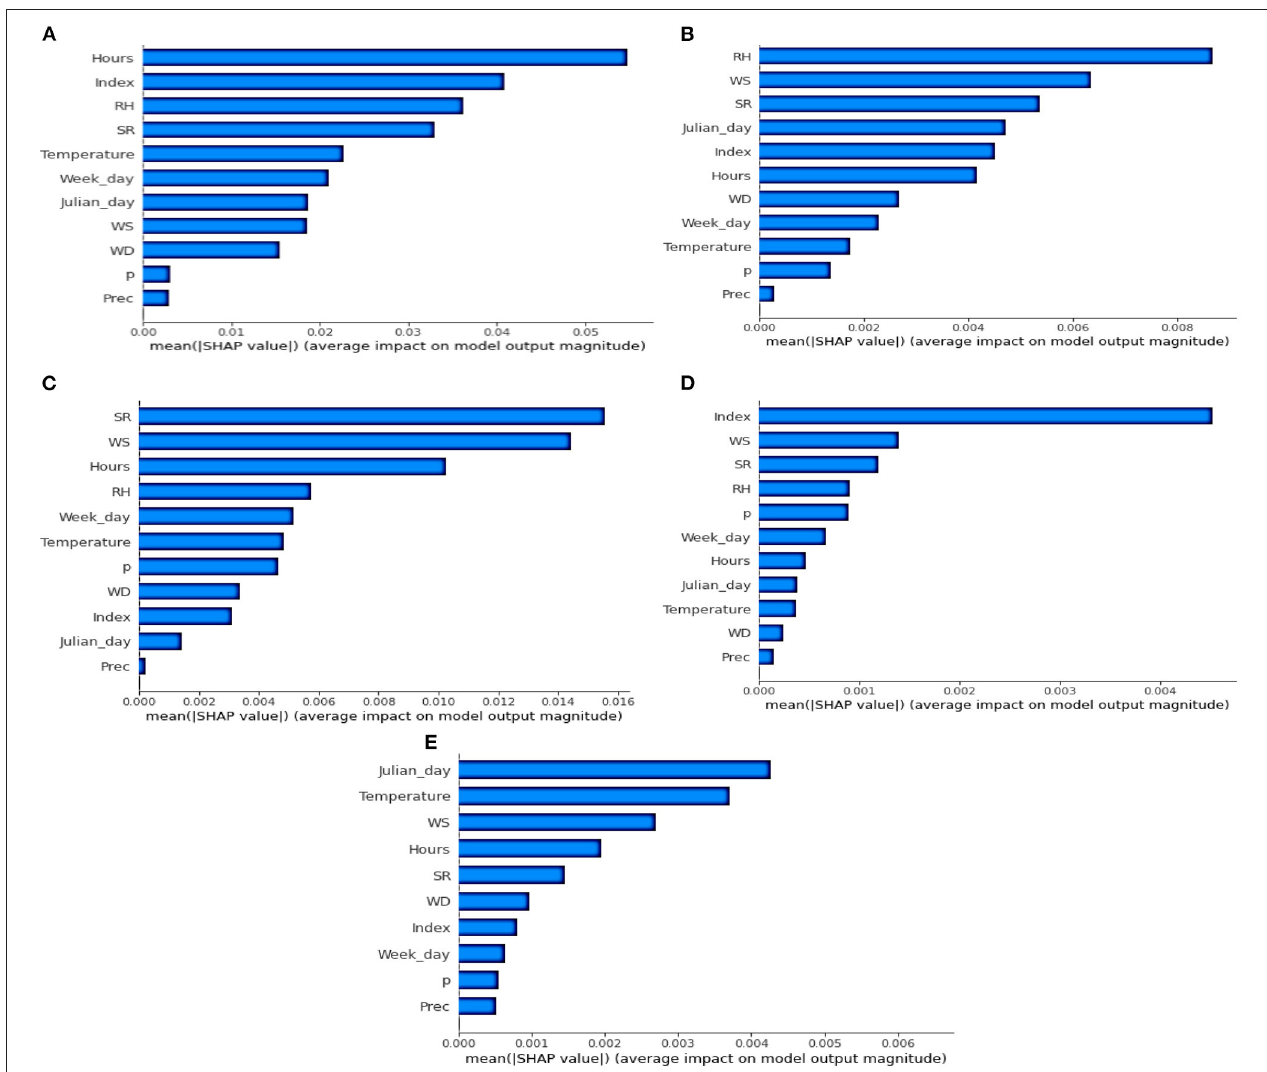
FIGURE 6 | Variable importance with mean (|SHAP value|) for the five best models. (A) O 3 (B) CO (C) NO 2 (D) SO 2 (E)